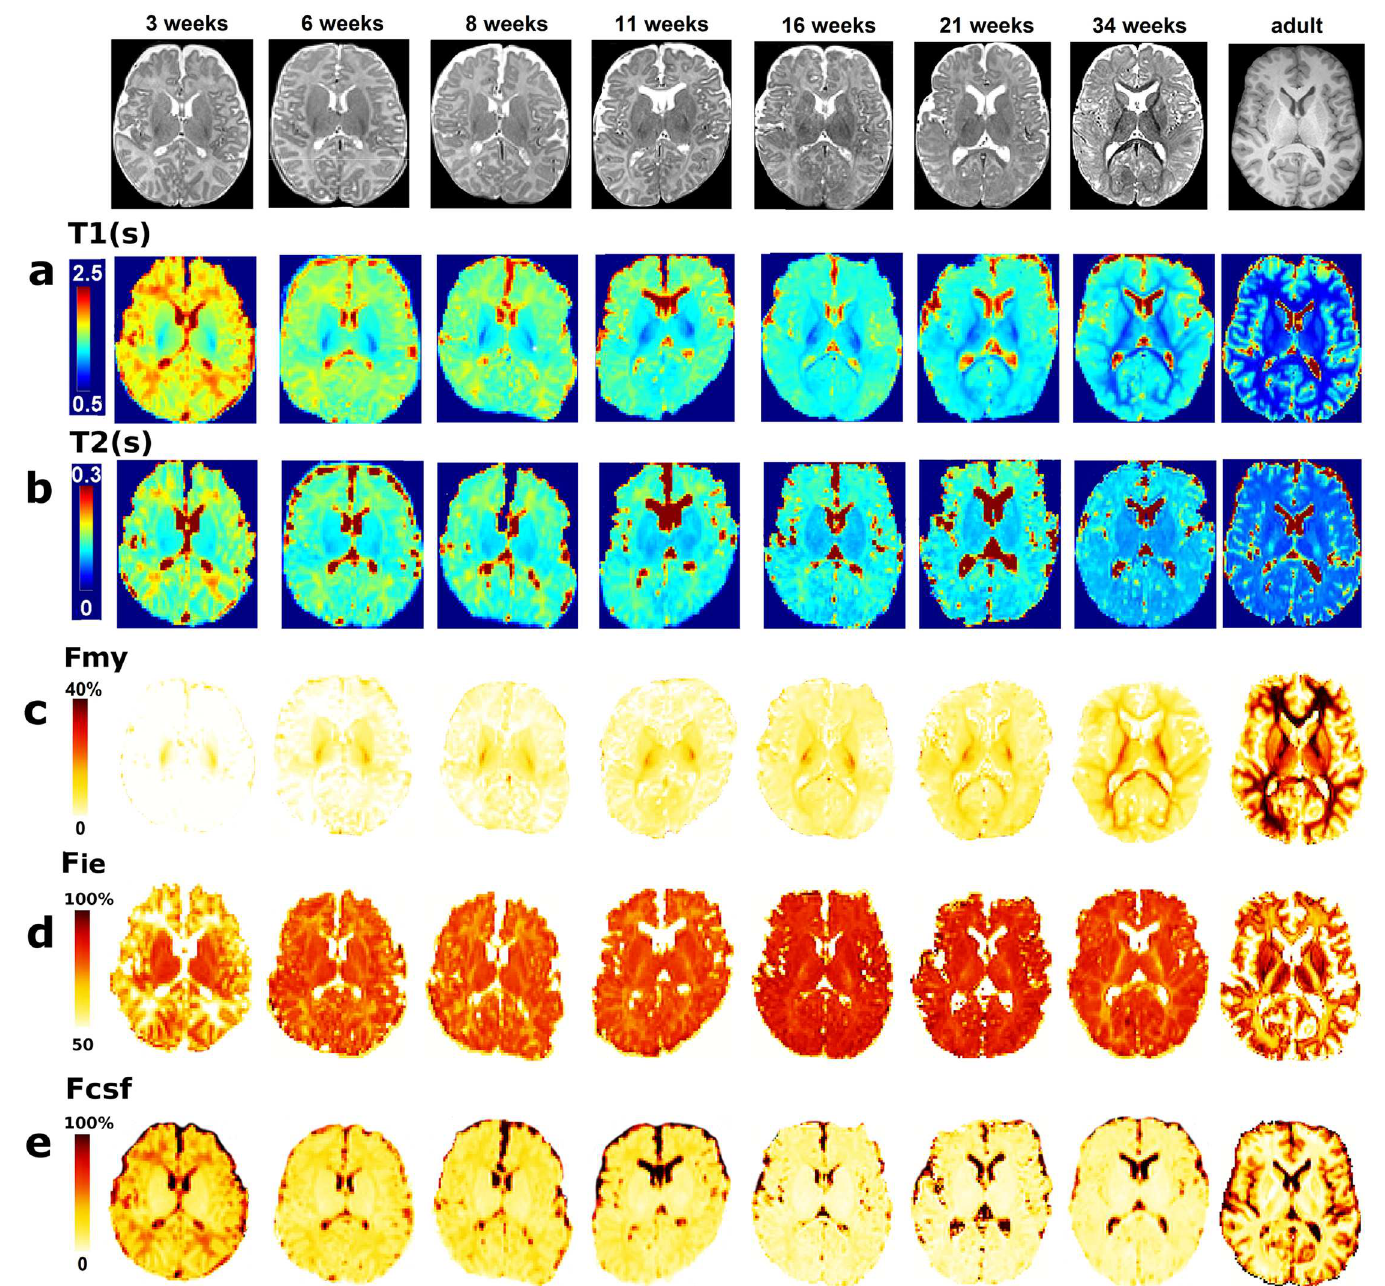
Fig 5. T1, T2 and fraction maps computed in reduced datasets. Quantitative T1 (a) and T2 (b) maps are presented for infants at different ages and for an adult subject, with corresponding anatomical images (T2w for infants / T1w for the adult). Axial slices are displayedin radiologicalconvention. T1 and T2 maps show the expecteddecreaseswith age. Fraction maps for the compartments of myelin-related water f my (c), intra/extra-cellular water f ie (d) and unrestricted water f csf (e) obtainedat the testing stage are also presented. In agreement with the known age-related decrease in water content, f csf decreasedwith age in most voxels except in the CSF, while f my increasedin white matter regionswith myelination. Interestingly, the early increase in f ie during infancy was followedby a decrease from 34 weeks on in locationswhere f my showed concomitant sharp increase (i.e. posterior limb of the internal capsule and optic